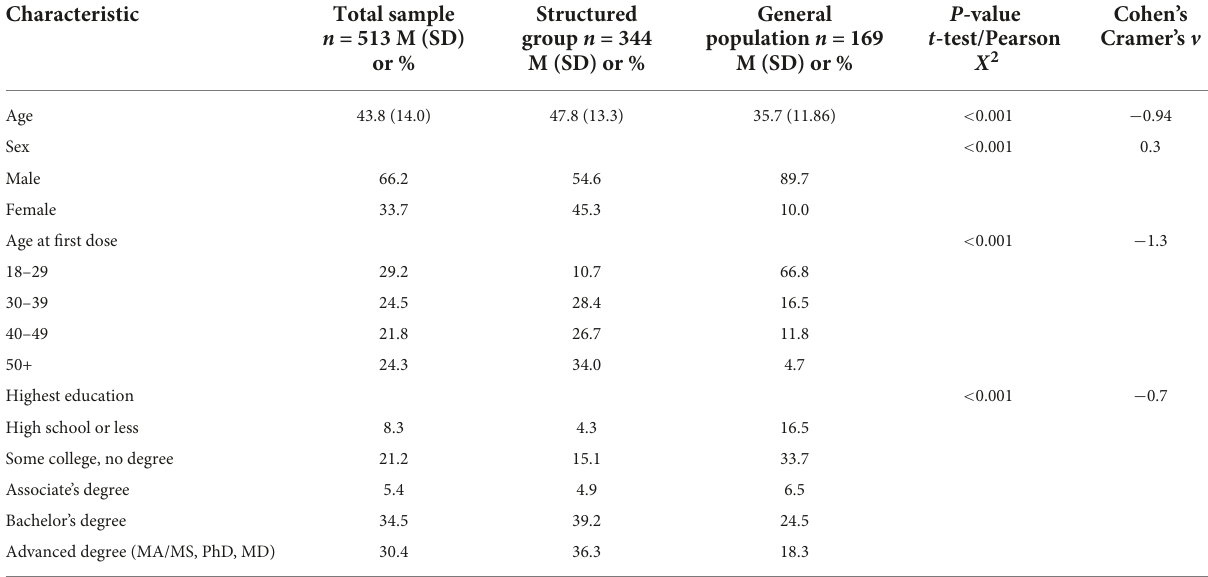
TABLE 1 Demographic characteristics of study